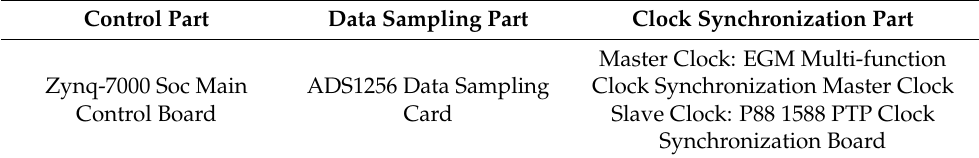
Table 1. Device composition table of different components in the